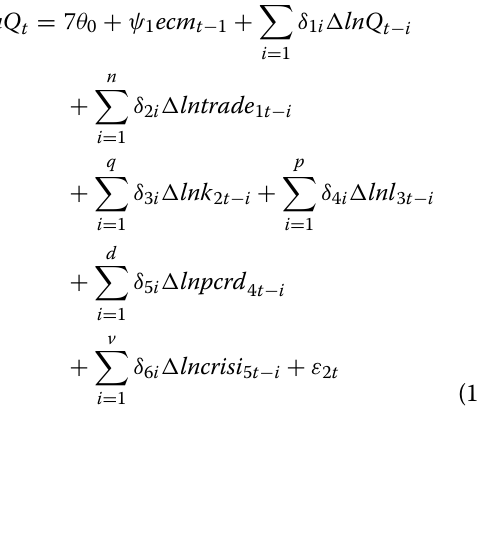
a, b and c indicate 1%, 5% and 10% level of significance [] is the maximum